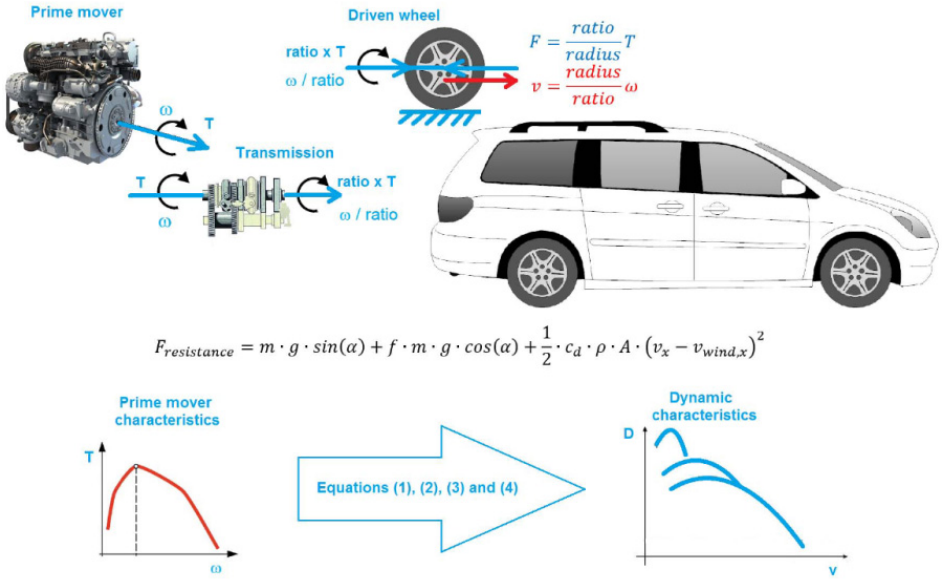
Figure 6. Simplified calculation scheme.